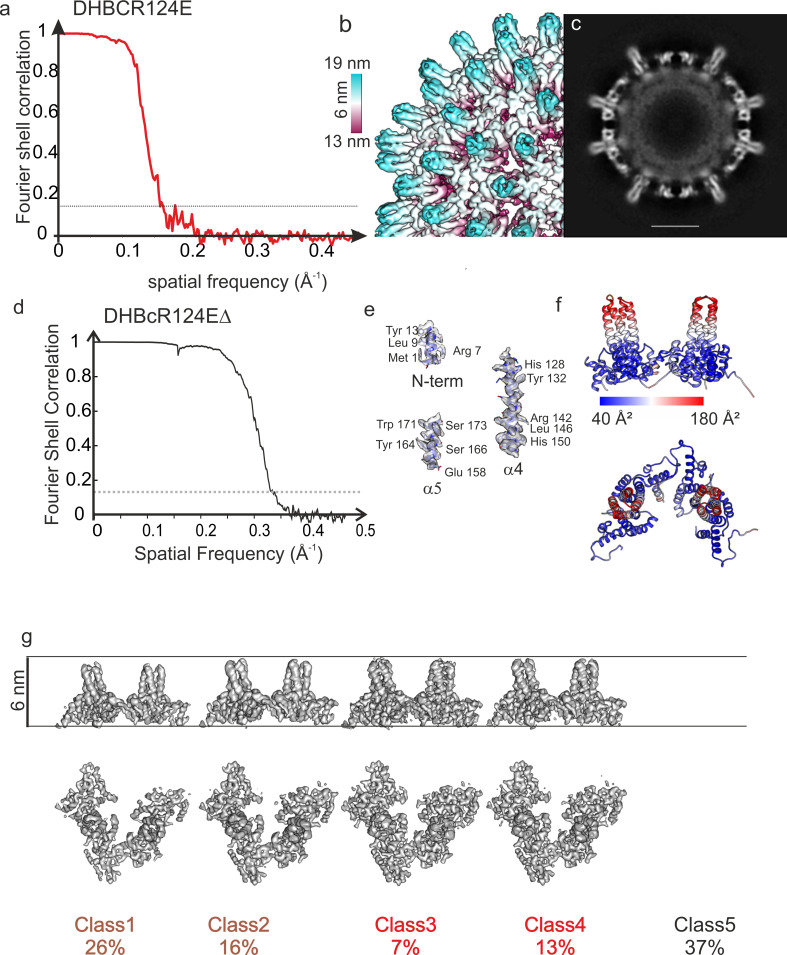
Structural characterization of DHBcR124E and DHBcR124EΔ.(a) Fourier Shell correlation after gold standard refinement of DHBCR124E. The dashed, grey line indicates a Fourier-Shell Correlation of 0.143, which was used as threshold for determining the resolution of 6 Å. (b) Close-up of the surface representation of the image reconstruction of DHBcR124E showing narrow spikes. The surface is colored according to the radius as indicated by the color key. The length of the color key indicates 6 nm. (c) Equatorial slice of the image reconstruction in (b). There is no density visible for the extension domain indicating high flexibility. The scale bar indicates 10 nm. (d) Analysis of DHBcR124EΔ CLPs: Fourier Shell Correlation of CLPs of DHBcR124EΔ after gold standard refinement. The dashed line indicates a FSC of 0.143. The FSC-curve falls below the 0.143 threshold at a spatial frequency of 1/3 Å. (e) Selected areas of the map and model to highlight the quality of the side chain density. (f) Model of DHBcR124EΔ colored with the local B-factors from ADP-refine of Phenix. The color key is given below. The tips of the spikes have much higher B-factors than the rest of the subunit, suggesting high flexibility of the upper part of the helical bundle preceding the G2SG2 linker. (g) Surface representations of 3D-class averages from classification of the asymmetric units. All class averages are represented with the same density threshold. Class number and relative class occupancy are given below. At the chosen threshold Class5 shows no density and is indicative of holes at the respective regular positions in the capsids. Class1 (3.4 Å resolution) and class2 (3.3 Å resolution) are somewhat less dense than class3 (3.2 Å resolution) and class4 (2.9 Å resolution). The radial displacement between the four classes is less than 1 Å.